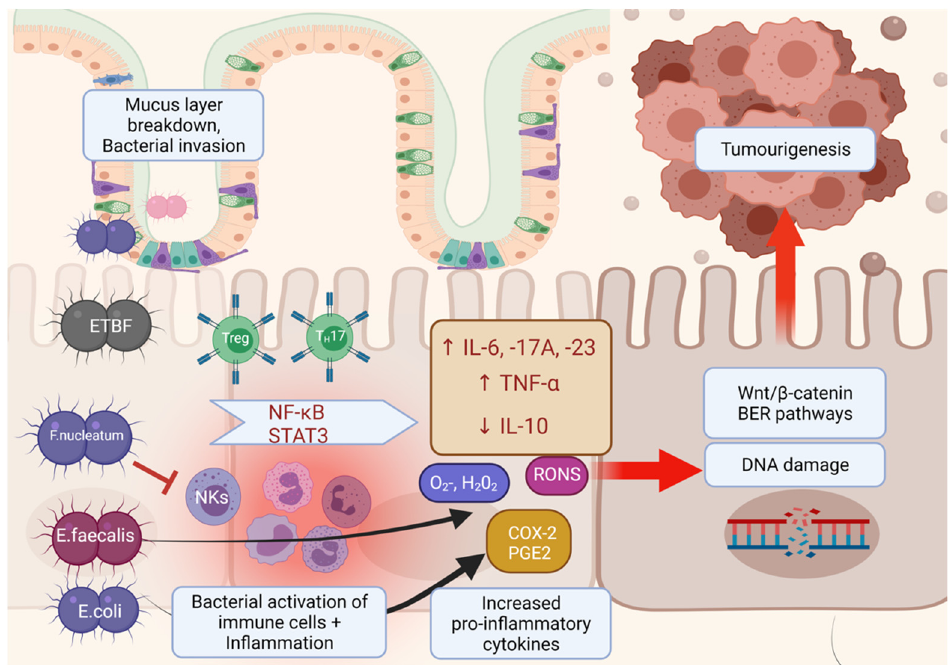
Figure 2. Interactions of immune response with gut microbiome facilitate CRC carcinogenesis. Dysbiosis of commensal bowel bacteria may compromise colonic epithelial barrier integrity, allowing pathogenic bacteria and their metabolites entry into the underlying stroma and promoting immune cell-mediated pro-inflammatory cytokine responses. In particular, E.faecalis is associated with NF- κ B-mediated pro-inflammatory IL-6 and IP-10 gene expression. F.nucleatum is associated with IL-17A and TNF- α expression, as well as inhibiting T cell activation and natural killer cells (NKs). The presence of ETBF in the mucosa is correlated with Treg-induced Th17 production of IL-17A. Pks+-harbouring Escherichia coli is associated with COX-2 and PGE-2 pro-carcinoma responses. These pro-inflammatory responses can induce DNA damage and the induction of the Wnt/ β -catenin and base excision repair (BER) pathways, thus increasing the risk of cell proliferation, transformation into carcinoma and subsequent